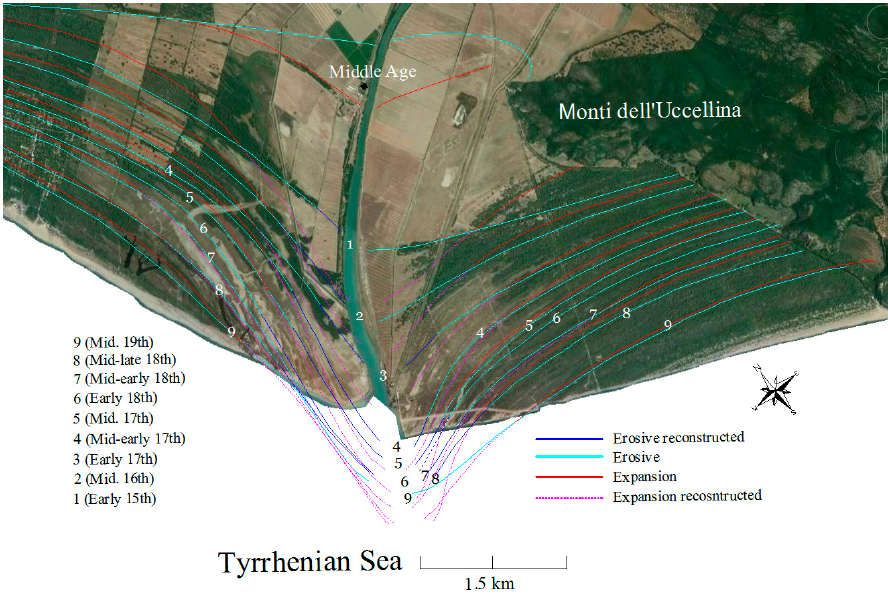
Figure 6. Beach ridges reconstruction for main historical phases from the 15th to the 19th century.